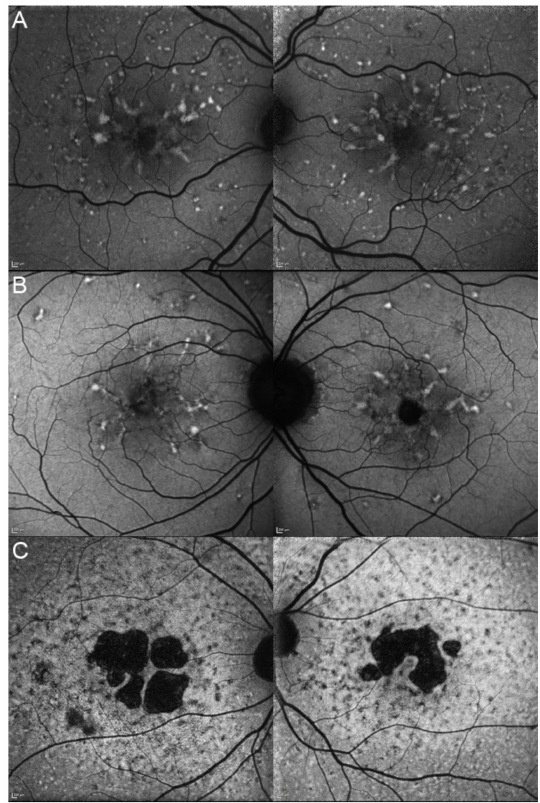
Figure 11. Fundus autofluorescence imaging of patients harboring the pathogenic c.422A>G p.(Tyr141Cys) PRPH2 variant. Patient 17/II.1 ( A ), patient 18/II.2 ( B ), patient 19/III.2 ( C ). For each patient, the left panel shows the right eye, and the right panel the left one. The FAF findings are described in detail in Table 2.